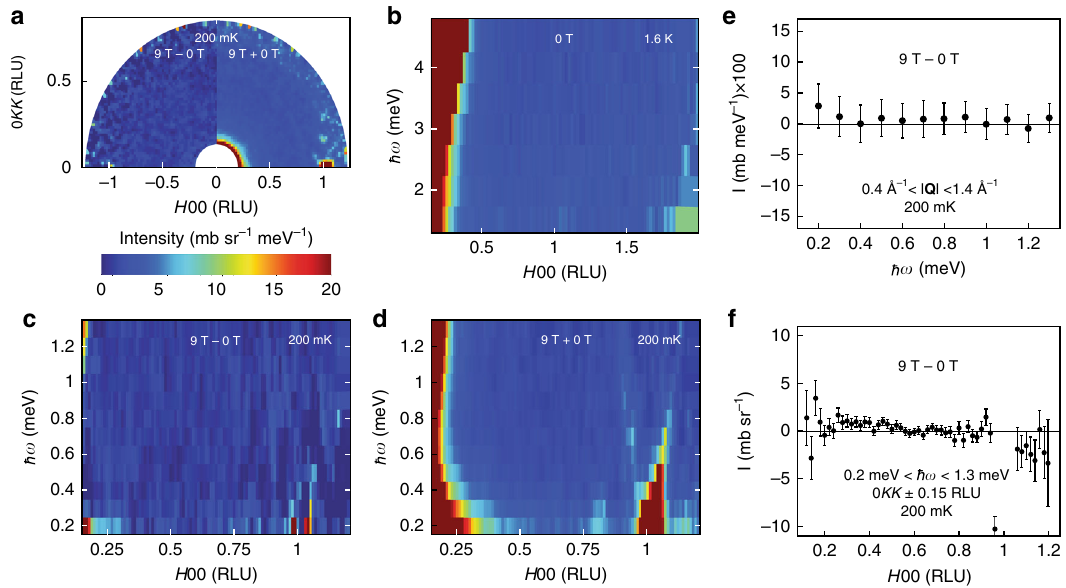
Fig. 4 Low energy neutron scattering of SmB 6 taken at 1.6K and 200mK. a Energy integrated from 0.2 to 1.3meV. Left shows 9T data with the 0T data subtracted (9T − 0T). Right shows the data sets averaged (9T + 0T). No substantial scattering is apparent in either, aside from the Bragg tail at 100 and low j Q j background scattering. b 0T data from 1.5meV to 5meV. Only residual Bragg/phonon scattering is present. c 9T − 0T data. There is no discernible fi eld dependence of the low energy scattering. d Average of 9T and 0T data. The only substantial signal is residual Bragg scattering and weak phonon scattering at (100), along with a background powder ring at 0.8 RLU (seen as a very weak ring in the right side of ( a ). Again, no magnetic scattering is evident. e 9T − 0T Scattering integrated from 0 : 4Å (cid:2) 1 < j Q j < 1 : 4Å (cid:2) 1 . This includes all scattering in the HKK plane between the low angle limitation of the instrument and the fi rst Bragg peak, and shows no evidence of magnetic scattering. f 9T − 0T scattering integrated from 0.2meV to 1.3meV. No fi eld-dependent scattering is evident. The only substantial deviation from zero occurs at the 100 Bragg peak, attributed to counting statistics as seen in c . Error bars described in